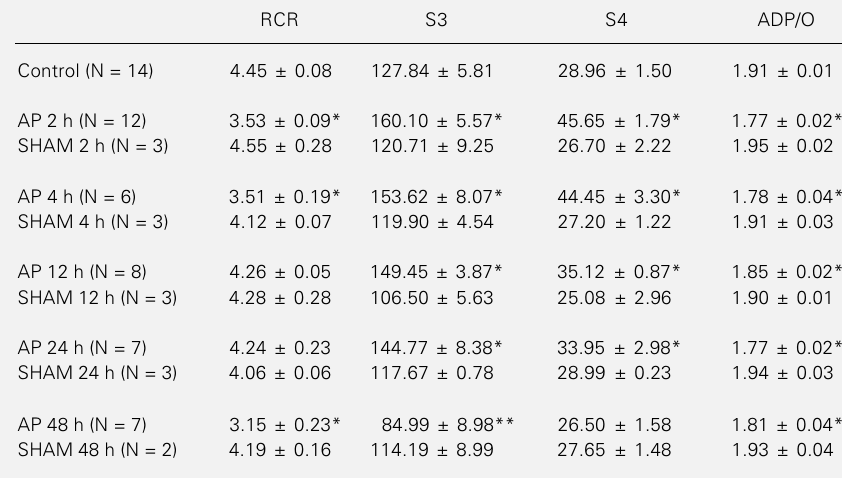
Table 3 - Oxidation and phosphorylation activities of mitochondria in experimental acute pancreatitis. Data are reported as means – SD. S3 and S4 = Oxygen consumption in ng atoms of O 2 min -1 mg protein -1 ; RCR = S3/S4. *P<0.05 compared to control and sham groups (analysis of variance); **P<0.05 compared to control, AP 2, 4, 12, 24 h and sham groups (analysis of